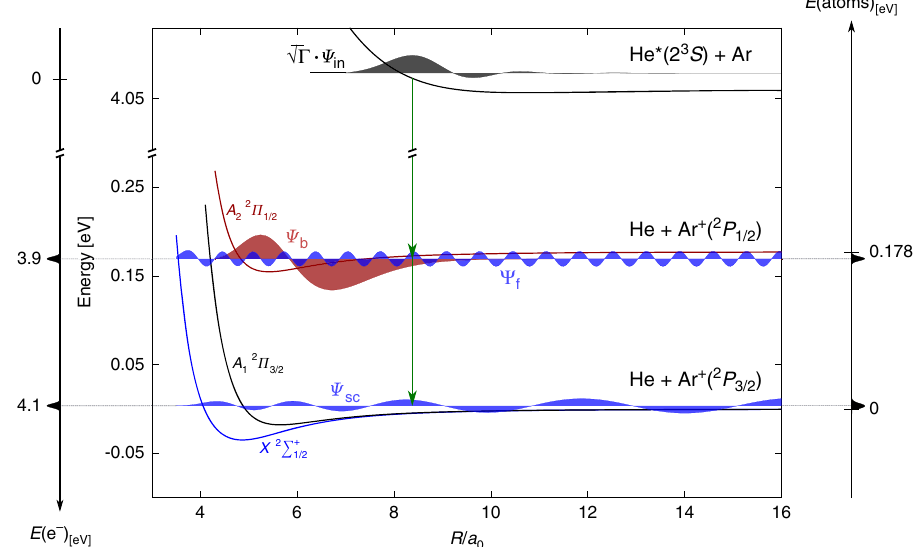
Fig. 1 Potential energy curves. PECs obtained from refs. 38,39 . Ψ in represents the incoming wave function with wave number matching an energy of k B × 220 K. Ψ b represents the fi rst excited vibrational level of HeAr + at the A 2 electronic state. Ψ f represents the scattering state wave function of the X state that couples to Ψ b . Ψ sc represents the scattering state wave function of the X state with maximal overlap with distribution of ejected electrons and E (atoms) represents the energy distributed between He and Ar + ( 2 P 3/2 ). All wave functions were calculated using discrete variable representation 40 , the resonance width Γ ( R ) is taken from ref. 41 .